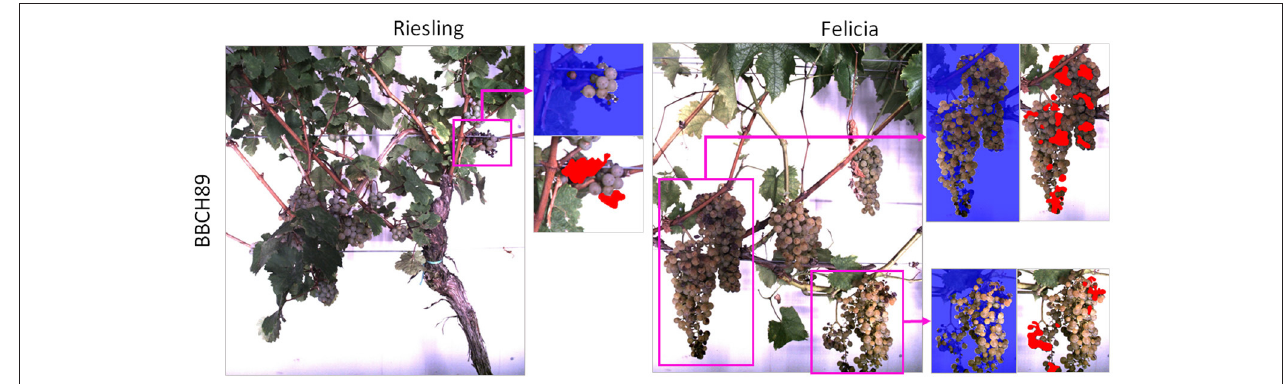
FIGURE 2 | Examples from the images showing damaged grapevine berries. Damaged regions are highlighted with pink boxes. The blue masks in the image patches are the result of the pre-processing step of our proposed pipeline (refer to Section 2.3). The red areas in the patches are the manual damage